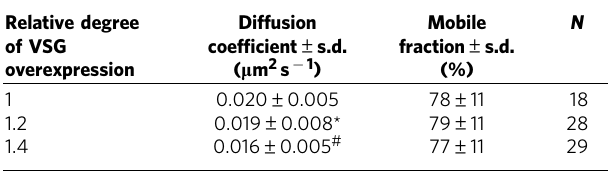
VSG, variant surface glycoprotein. P value of the diffusion coefficients of a two-tailed and unpaired t -test compared with a degree of overexpression of 1: P * 4 0.03, P # ¼ 0.005